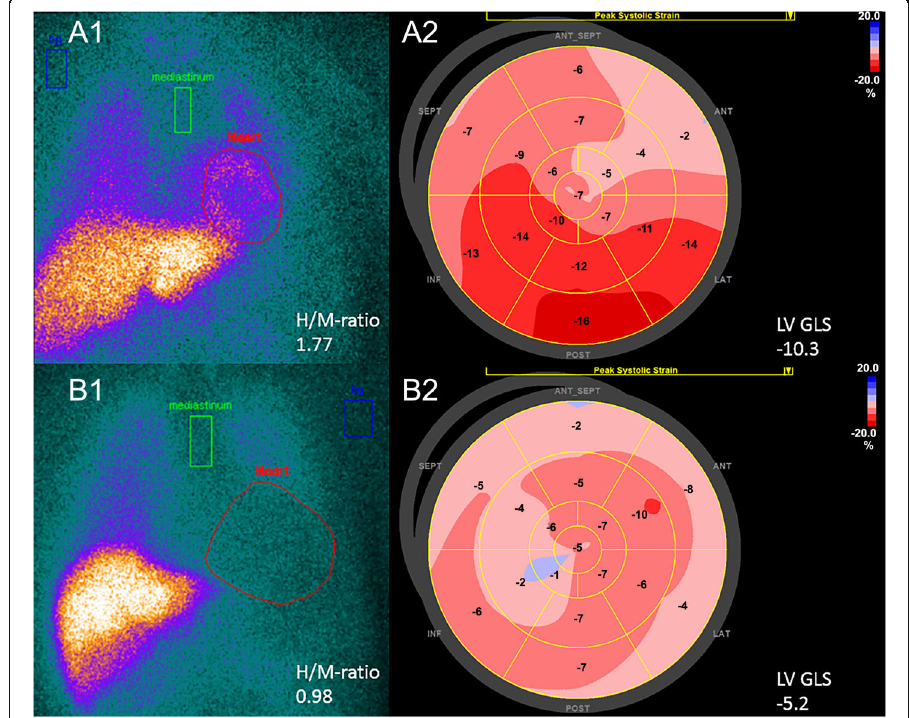
Fig. 1 Example of H/M-ratio and LV GLS. Example of heart-to-mediastinum (H/M) ratio on planar images ( A1 and B1 ) and left ventricular (LV) global longitudinal strain (GLS) ( A2 and B2 ) of two patients. Patient A, 70-year-old male, with ischemic cardiomyopathy, left ventricular ejection fraction (LVEF) 34%. Patient B, 72-year-old male, with ischaemic cardiomyopathy, LVEF 25%. Patient A did not experience an event, whereas patient B experienced appropriate ICD therapy